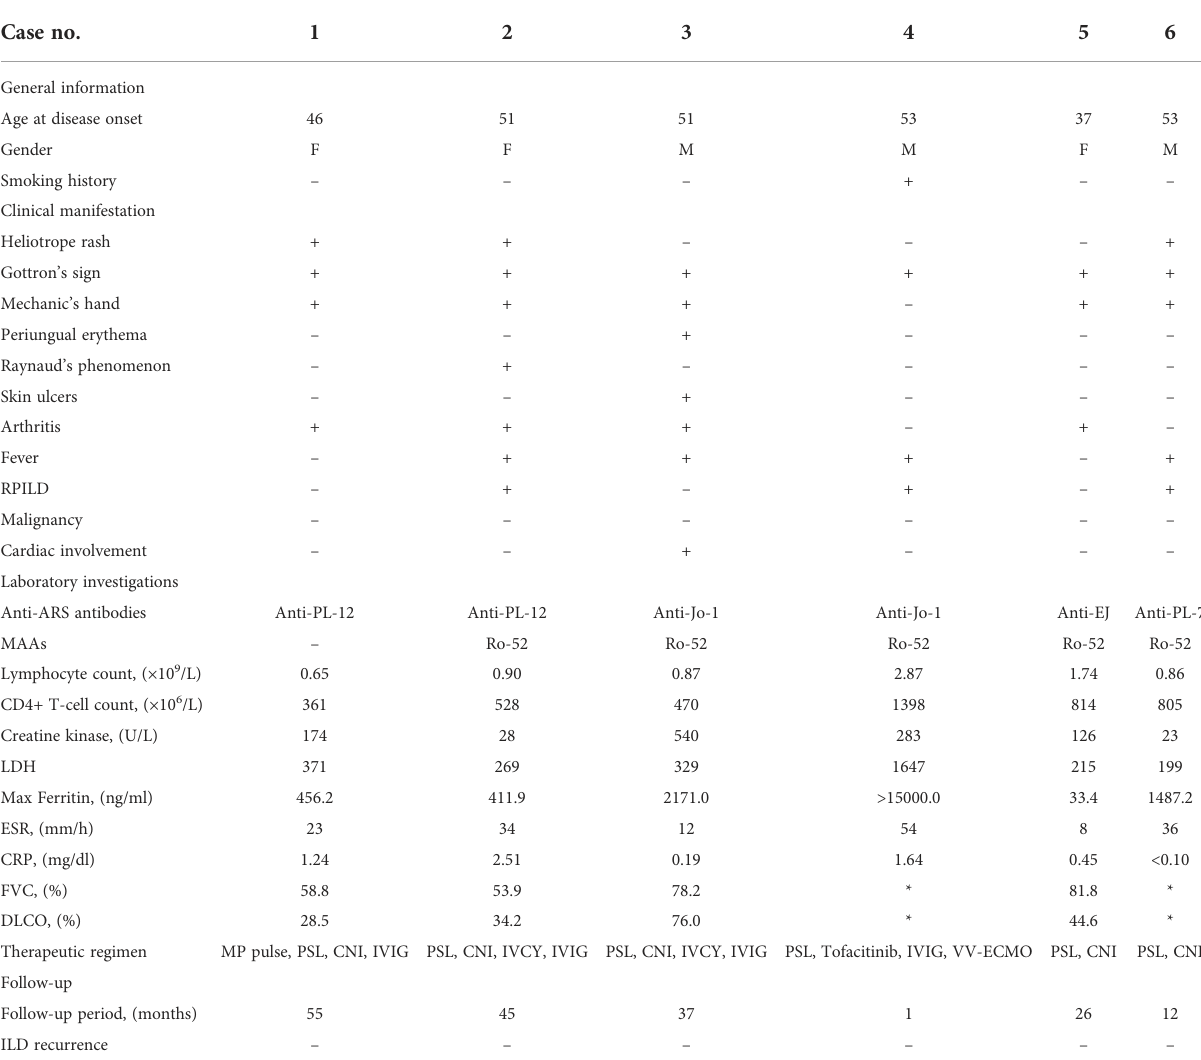
TABLE 1 Characteristics of six anti-MDA5+/ARS+ dermatomyositis cases. Case